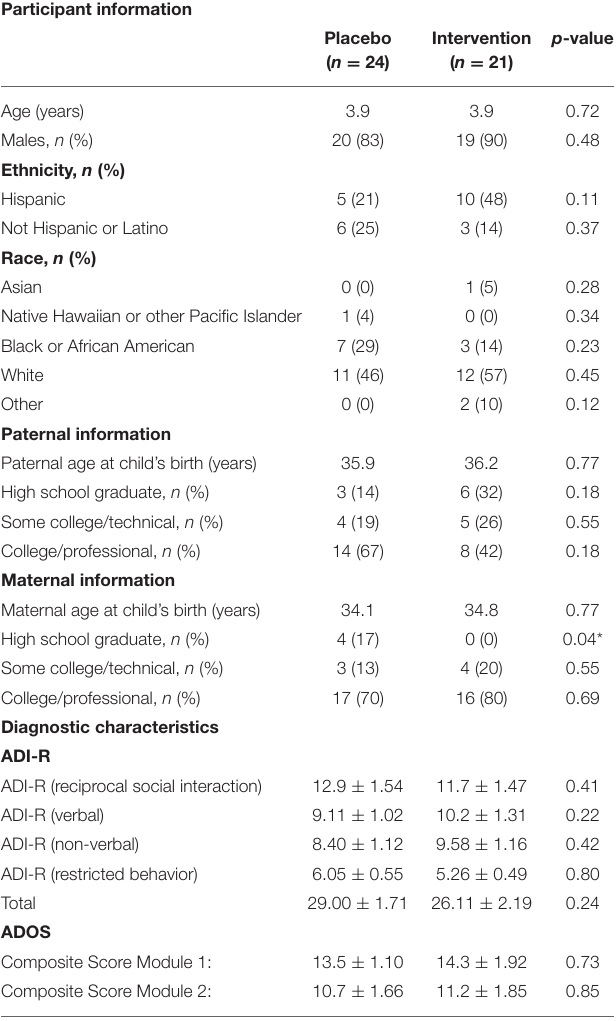
TABLE 1 | Demographic information for placebo and intervention groups taken at